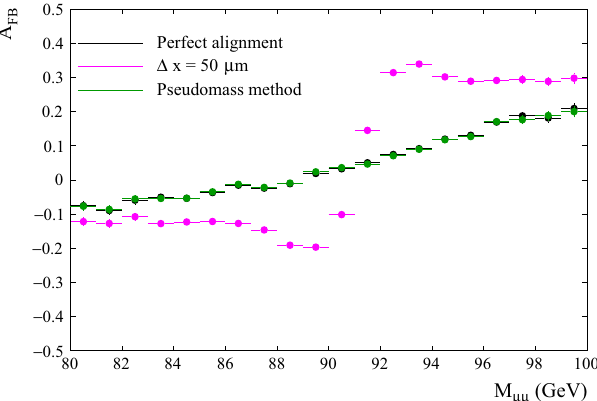
Fig. 6 The dimuon invariant mass distribution (left) and the forward backward asymmetry in bins of the dimuon invariant mass (right), for simulated events with a coherent Δ x = 50 μ m (magenta), after applying